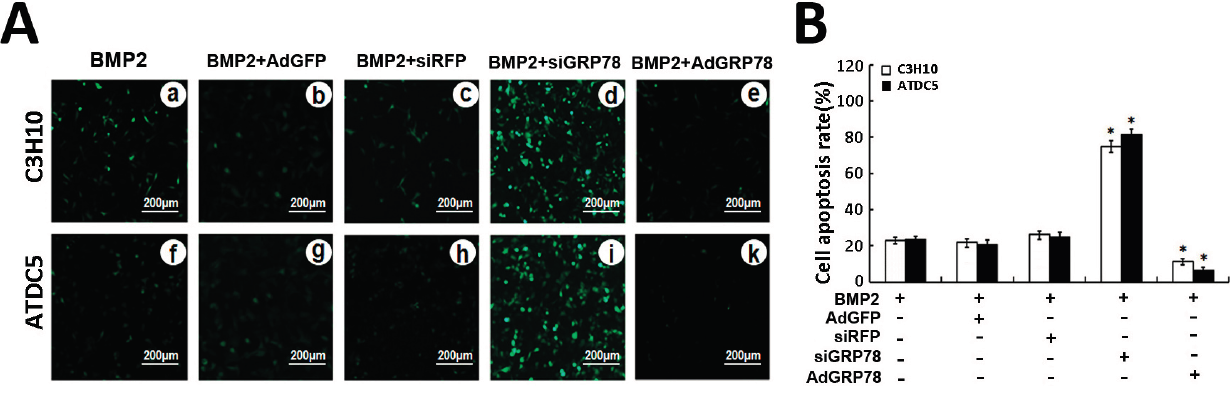
Figure 7. Ad-GRP78 inhibits, while siGRP78 increases, ER stress-mediated apoptosis in micromass culture of ATDC5 cells and C3H10T1/2 cells induced by BMP2. ( A ) After treatment with 300 ng/mL BMP2, BMP2 + Ad-GFP, BMP2 + Ad-GRP78, BMP2 + siRFP or BMP2 + siGRP78 in micromass culture of C3H10T1/2 cells ( a – e ) and ATDC5 cells ( f – k ), then were analyzed for apoptosis using the TUNEL staining assay. Representative photographs of TUNEL staining in cells. The FITC-labeled TUNEL-positive cells were imaged under a fluorescent microscope (Bar = 200 μ m). The cells with green fluorescence were recognized as apoptotic cells, and the scale bars represent 200 μ m; ( B ) Analysis on cell apoptosis results. Data are mean ± SD for relative apoptosis normalized to control cells for three independent experiments. Columns mean of three separate experiments; bars represent SD. * p < 0.05 as determined by Student’s t -test, versus BMP2 + siRFP and BMP2 + siGRP78 group; BMP2 + Ad-GFP and BMP2 + Ad-GRP78 group. Representative images from TUNEL analysis are